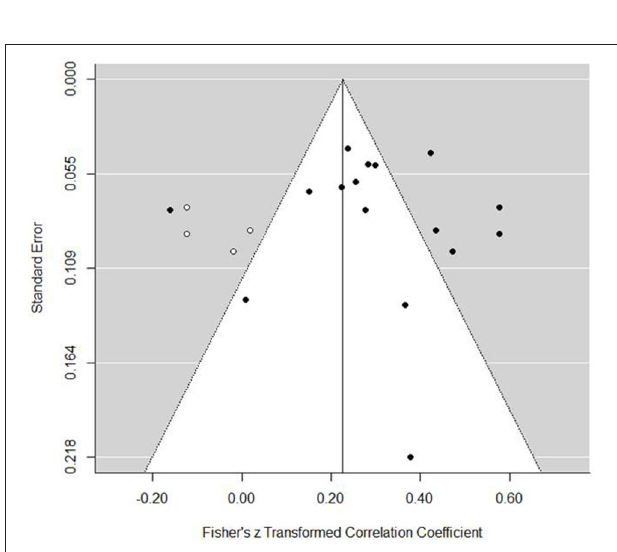
FIGURE 4 | Mastery coping funnel plot with trim and fill